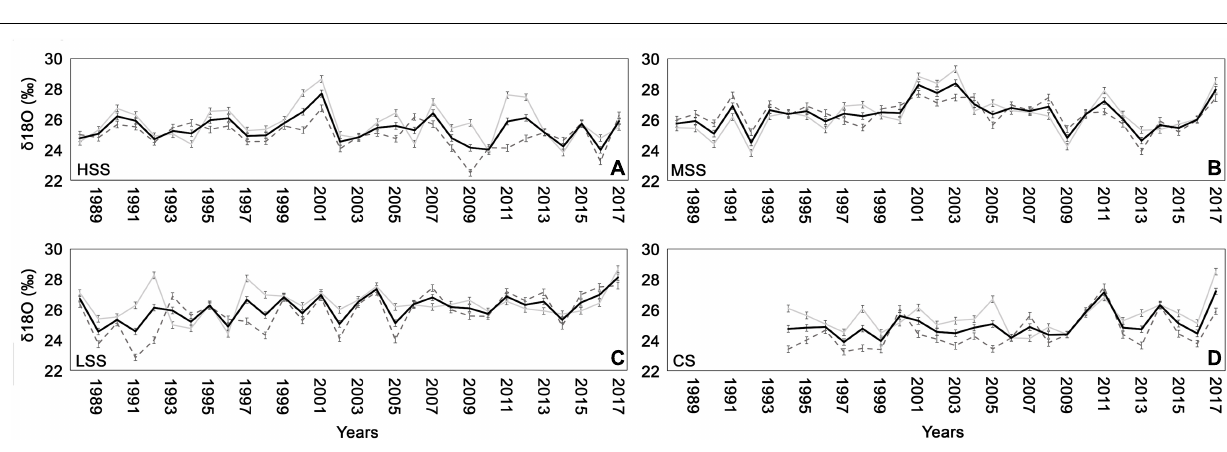
FIGURE 6 | δ 18 O chronologies ( ± standard deviation) for early-wood (gray line), late-wood (dashed gray line), and for the whole wood (black line) for (A) high severity site (HSS), (B) medium severity site (MSS), (C) low severity site (LSS), and (D) control site (CS).